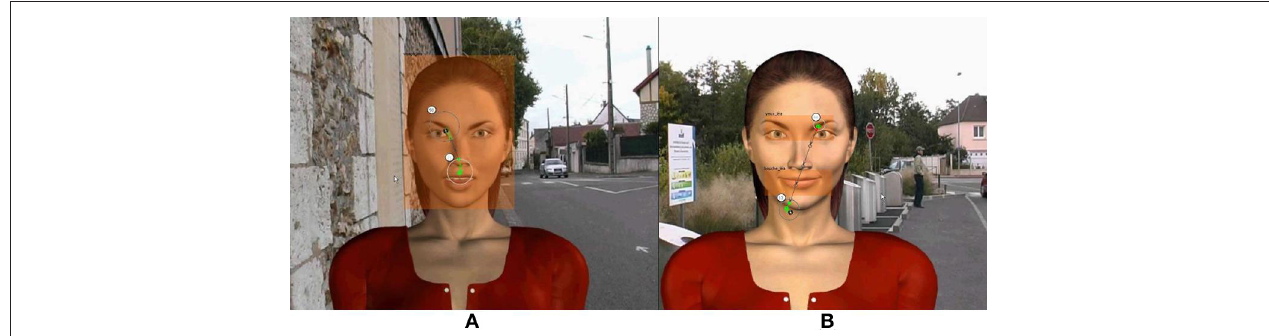
FIGURE 2 | The rectangular Area-of-Interest (AOI) used for analyzing gaze fixations. The circles represent consecutive fixations that are linked by the visual path. (A) the “face” AOI used; (B) the “eyes” and “mouth” AOI.